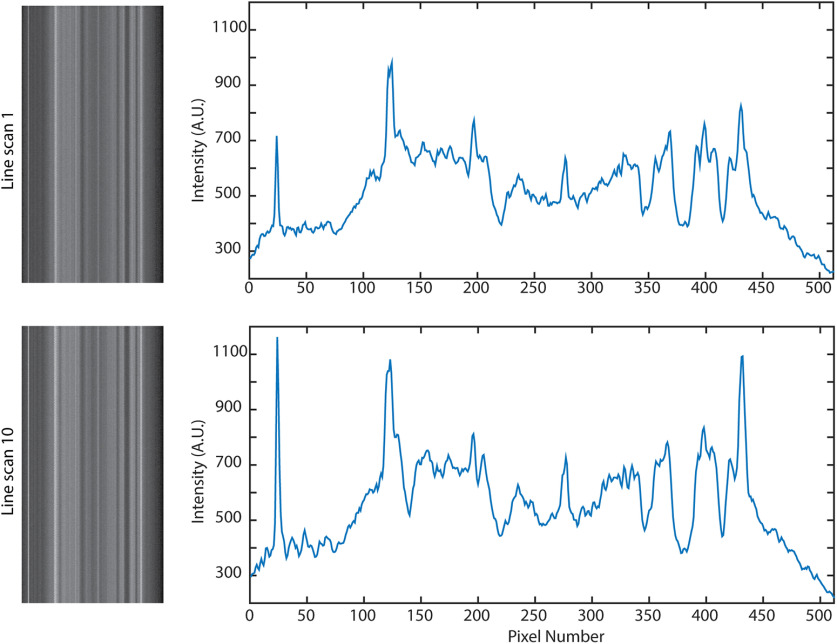
Consecutive line scans over the same area do not cause bleaching. Over 10 consecutive line scans (11 s each, during a 5 min period), the brightness did not decrease, although small changes have occurred due to movement.